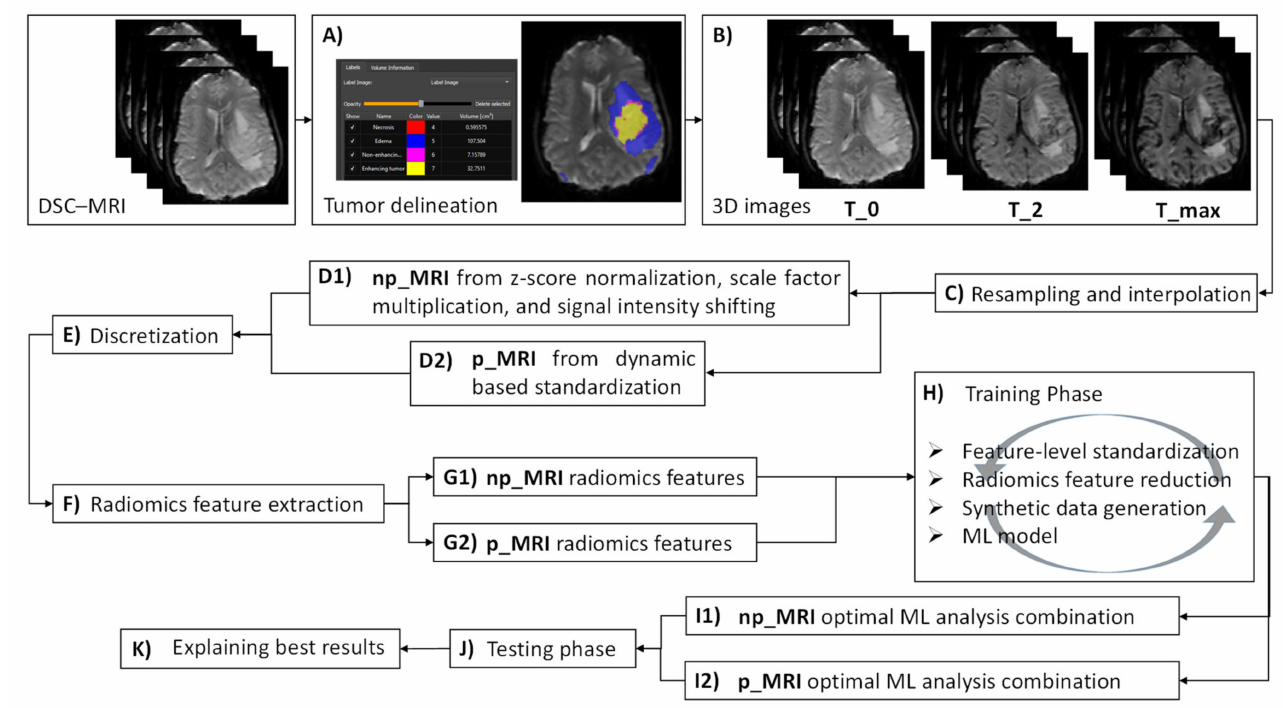
Figure 4. A schematic diagram summarizing the proposed radiomics analysis workflow